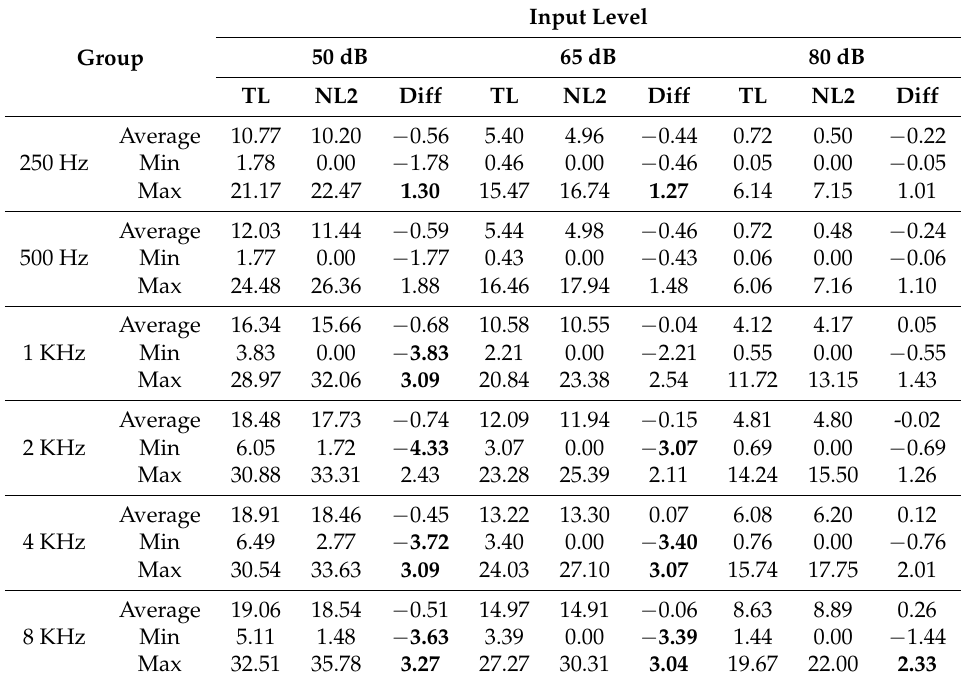
Table 3. Statistical analysis of